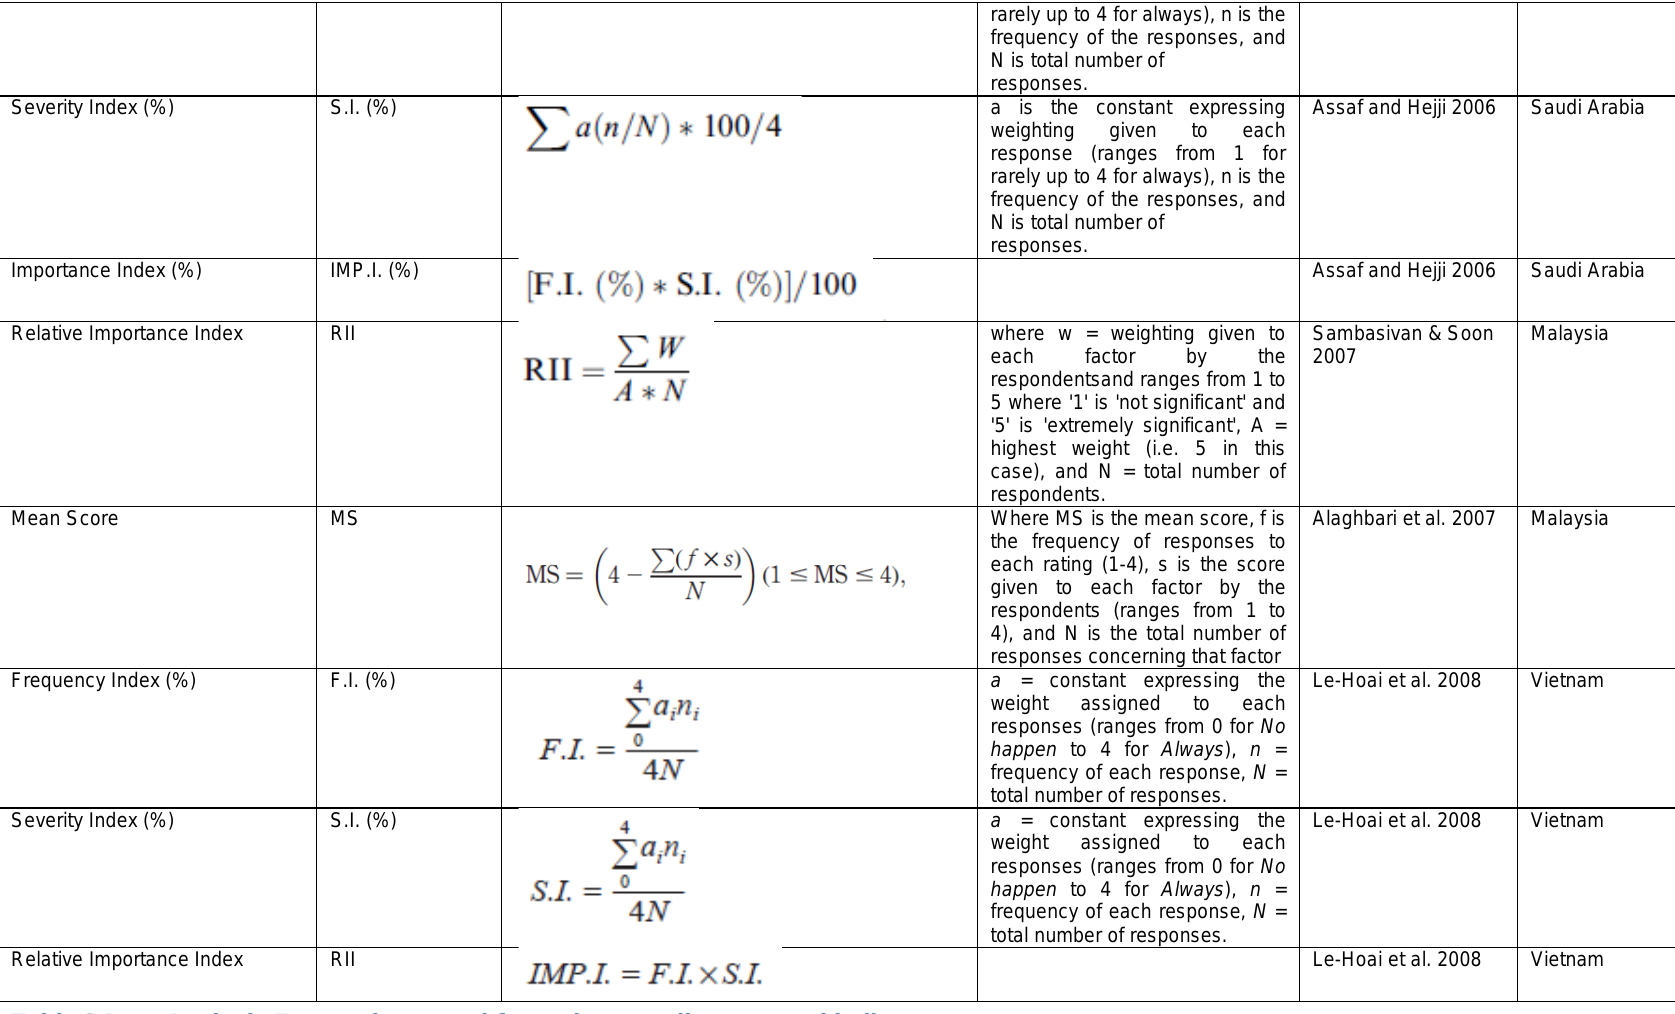
Table 3 Data Analysis Expressions used for various studies reported in